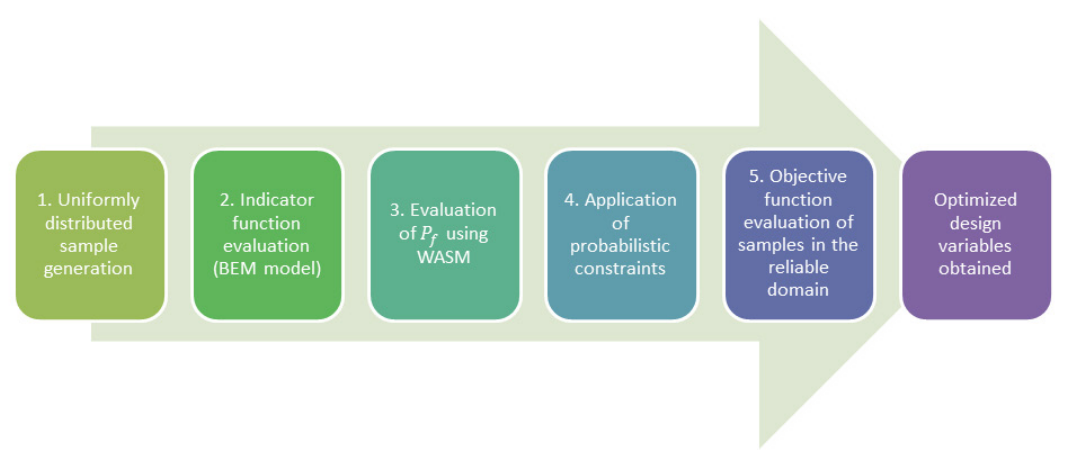
Figure 1. Flowchart of the proposed numerical approach.